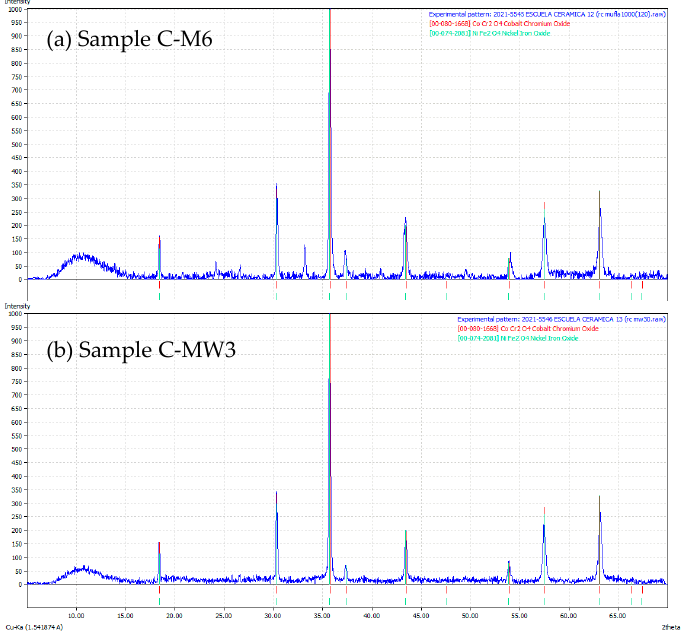
Figure 4. XRD of samples C-M6 ( a ) and C-MW3 ( b ) (red lines correspond to CoCr 2 O 4 XRD pattern (JCDPS 0801668) and light blue ones to NiFe 2 O 4 (JCDPS 0742081)). SEM micrographies (Figure 5) of these samples show well-formed aggregates where individual size was under 1 micron.